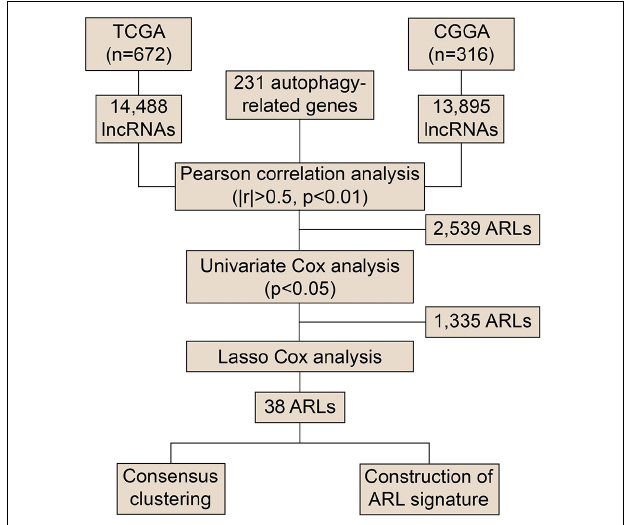
FIGURE 1 | Flow chart of screening